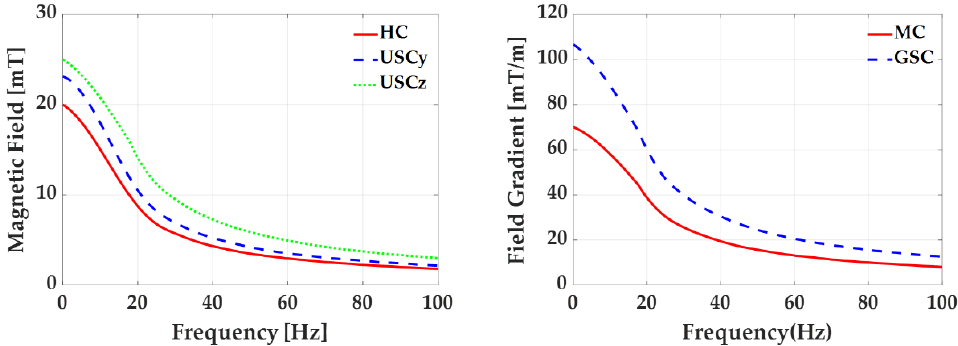
Figure 9. Calculated and measured maximum magnetic field or field gradient of each coil with a variation of frequency.